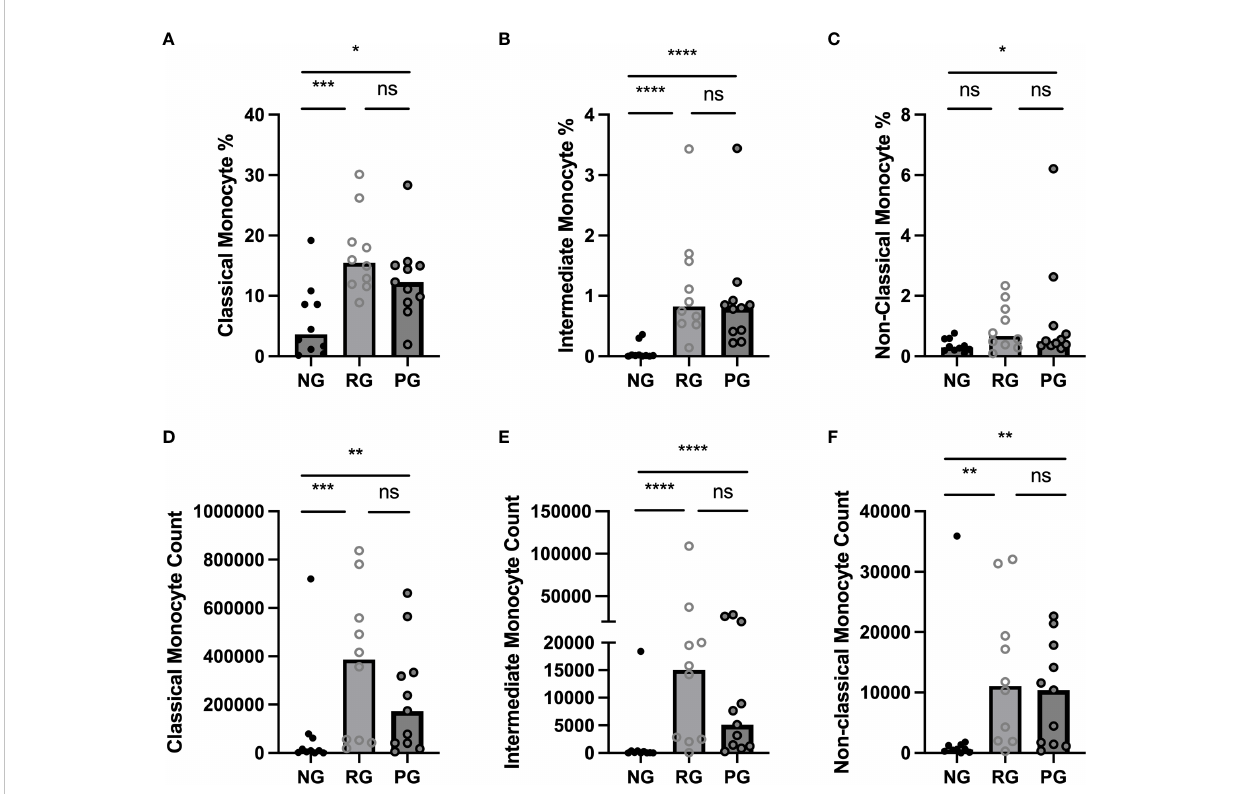
FIGURE 3 Comparison of circulating monocyte subsets among the groups. (A) Classical monocyte percentage, (B) Intermediate monocyte percentage, (C) Non-Classical monocyte percentage, as a proportion of total identi fi ed CD45 + cells in NG, RG, and PG groups. (D) Classical monocyte counts, (E) Intermediate monocyte counts, and (F) Non-Classical monocyte in NG, RG, and PG groups. Mann-Whitney-U Test *p < 0.05, **p < 0.01, ***p < 0.001, ****p < 0.0001, ns, non- signi fi